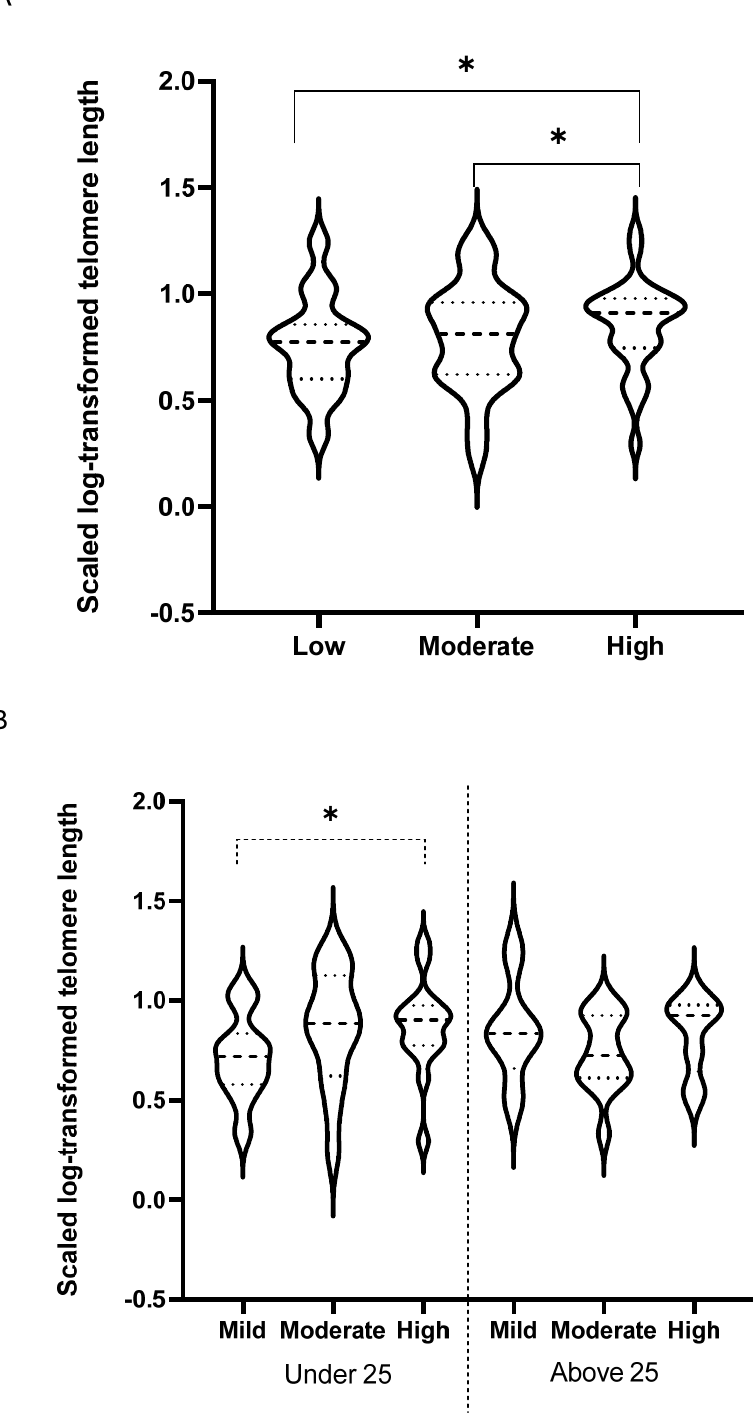
Figure 4. Comparing telomere length between age and sport intensity groups. Telomere lengths were compared between younger (less than 25 years old, n = 45) and older (more than 25 years old, n = 35) elite athletes ( A ) in different sport intensities (low, n = 18, moderate, n = 31 and high, n = 31) ( B ). Linear regression model was used to compare cytokine levels in different age and sport intensity groups taking gender and in/out of competition status as potential confounders. Data are presented as median and IQR. * p <0.05.